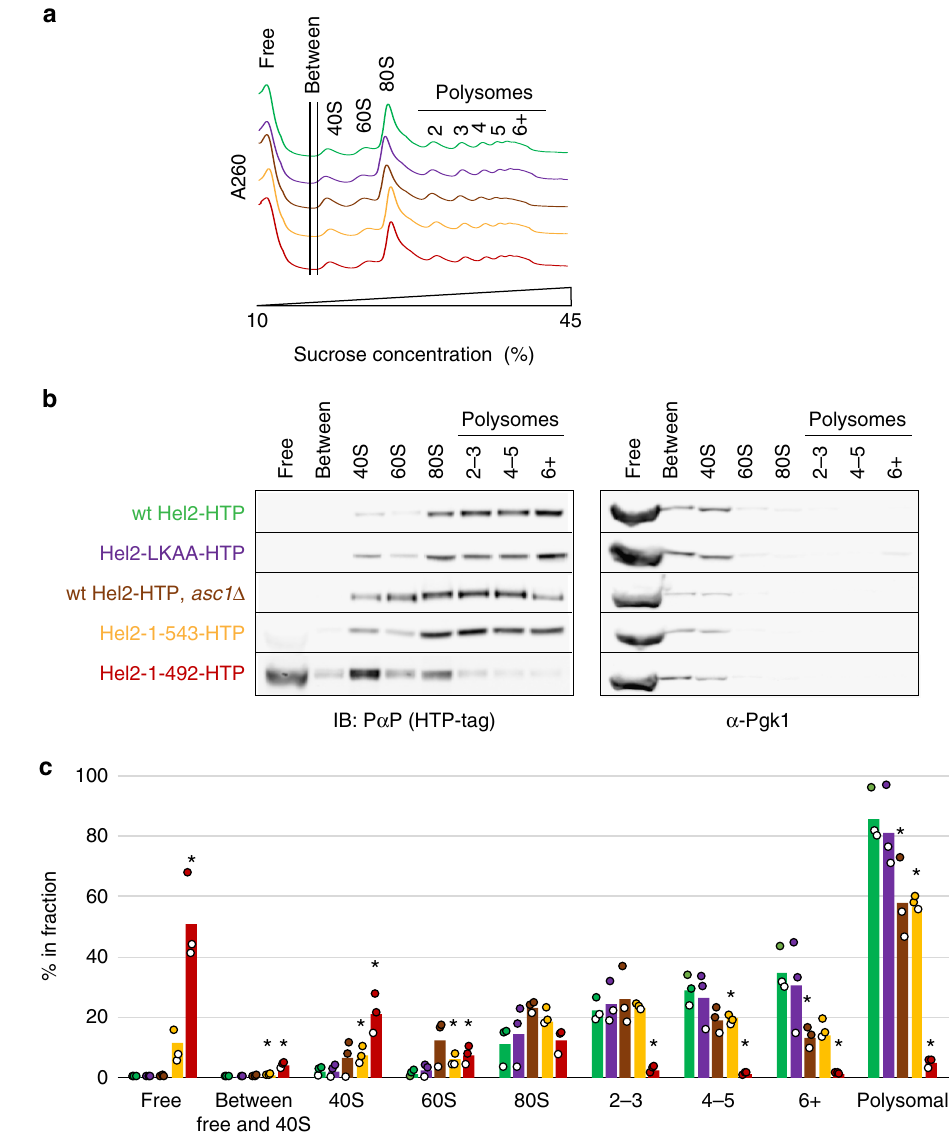
Fig. 6 Assessment of ribosome and polysome association of different Hel2 mutants. a Representative A 260 pro fi les (each curve normalized to a sum of 1) of sucrose density gradients from wild-type and mutant strains (see b for colour code and Supplementary Fig. 9 for triplicate quanti fi cation of signal in different fractions. b Immunoblot analysis of tagged Hel2 content in pooled and precipitated sucrose fractions containing different sub-populations of ribosomal components, monosomes or polysomes. Membranes were probed for the HTP-tag (using peroxidase-anti-peroxidase) and for Pgk1 as a control. c Quanti fi cation of tagged Hel2 content in each pooled fraction. Data were obtained from three independent biological replicates per strain (independently isolated clones). * p < 0.05, according to Student ’ s t test (two-tailed, paired, w.r.t. wild-type). See b for colour